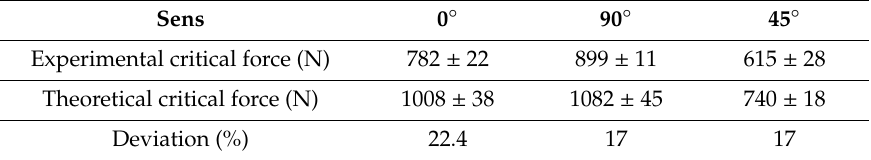
Figure 5. Load-relative displacement curve corresponding to ( a ) 0°, ( b ) 90° and ( c ) 45° specimens. Table 3. Comparison between theoretical and experimental values of the buckling test.